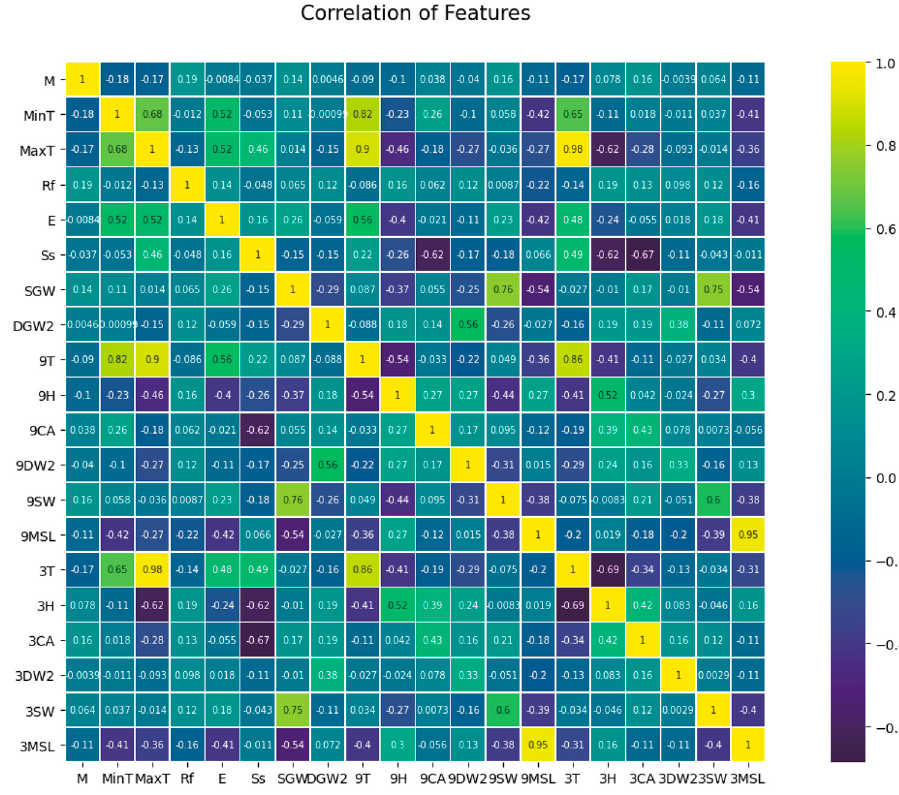
Figure 4. Correlations of each feature.